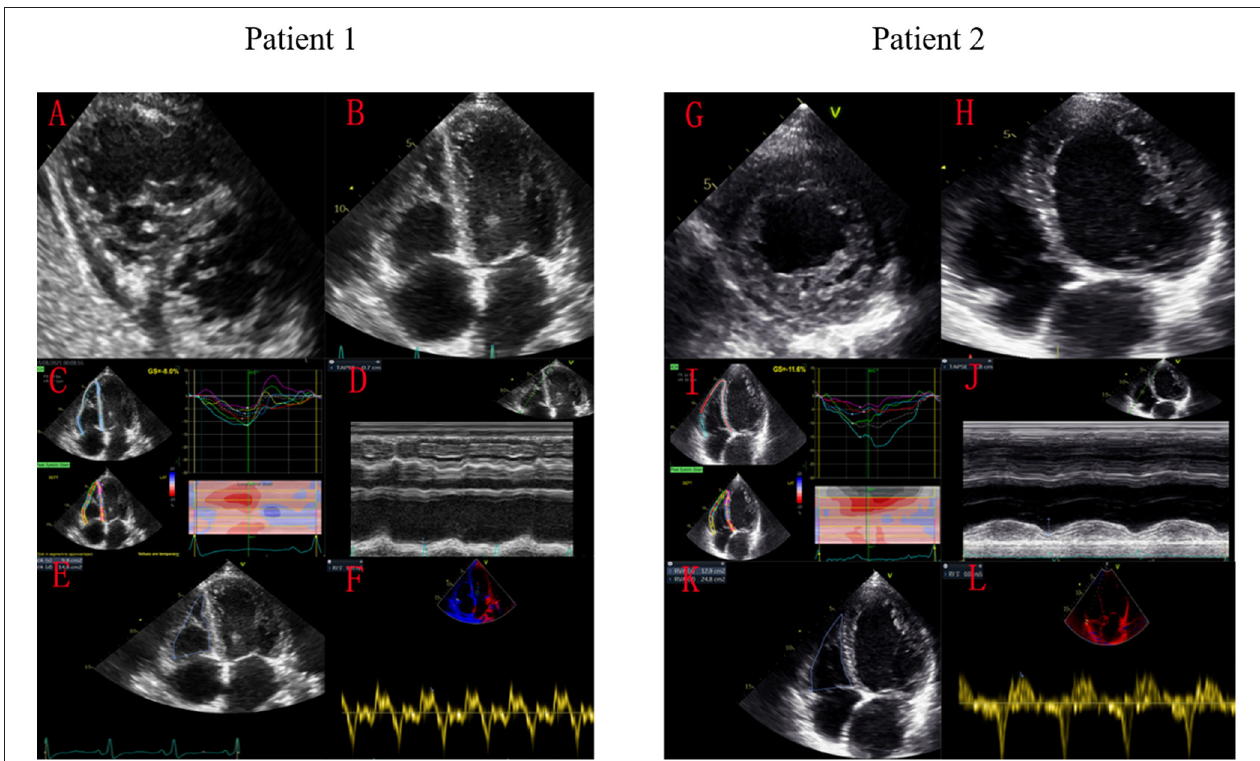
FIGURE 1 | Speckle-tracking echocardiography images of two patients with LVNC and the same LVGLS. Patient 1 with significant RV dysfunction died of cardiogenic shock, while patient 2 survived for long-term after treatment. Patient 1 had significant echocardiographic manifestations of RV non-compaction (A,B) . His RVGLS was − 8.0% (C) , TAPSE was 7mm (D) , RV FAC was 24% (E) , and tricuspid S ′ was 0.05 m/s (F) . Patient 2 only had LV echocardiography manifestations of ventricular non-compaction (G,H) . His RVGLS was − 11.6% (I) , TAPSE was 18mm (J) , RV FAC was 47% (K) , and tricuspid S ′ was 0.07 m/s (L)